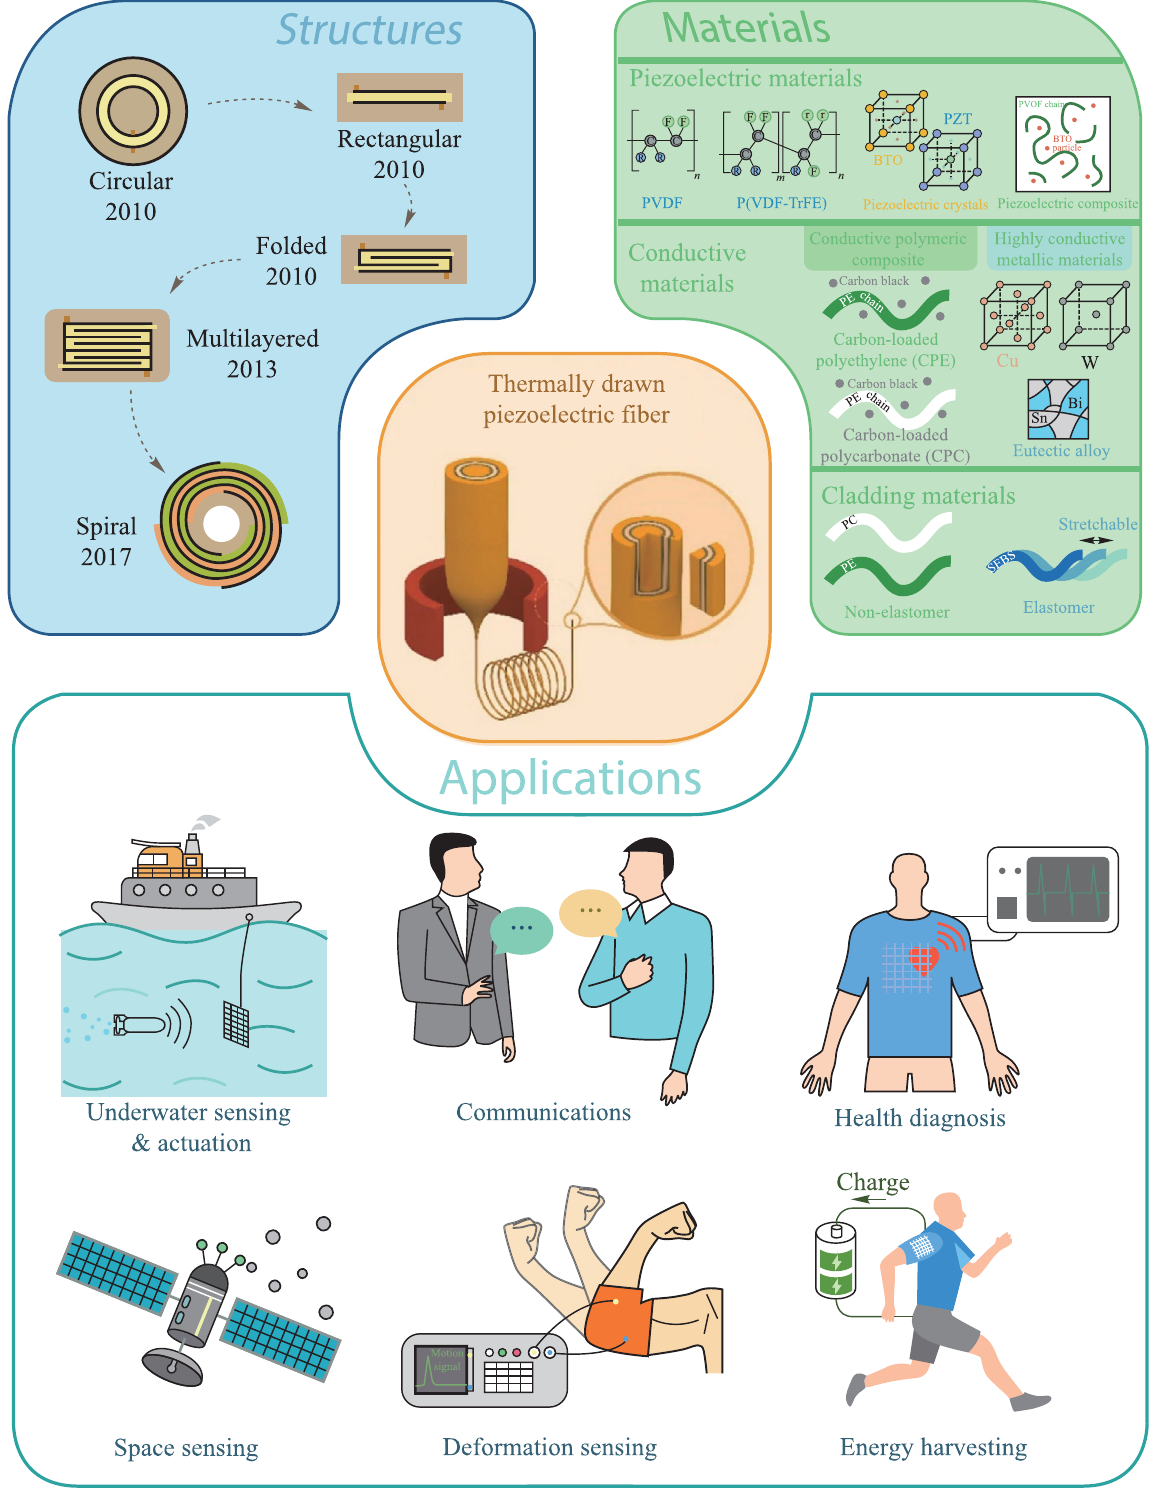
Fig. 1 Summary of the structures, materials and applications of the thermally-drawn piezoelectric fibers